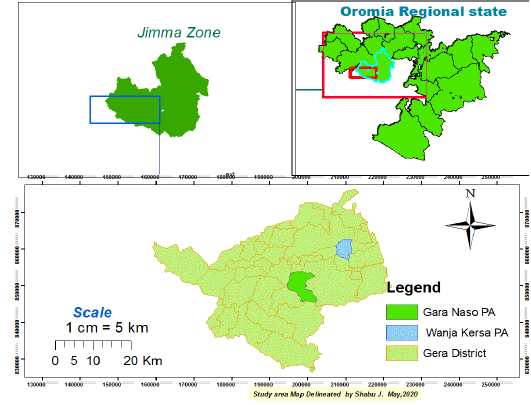
Figure 1 Map and study of location of study